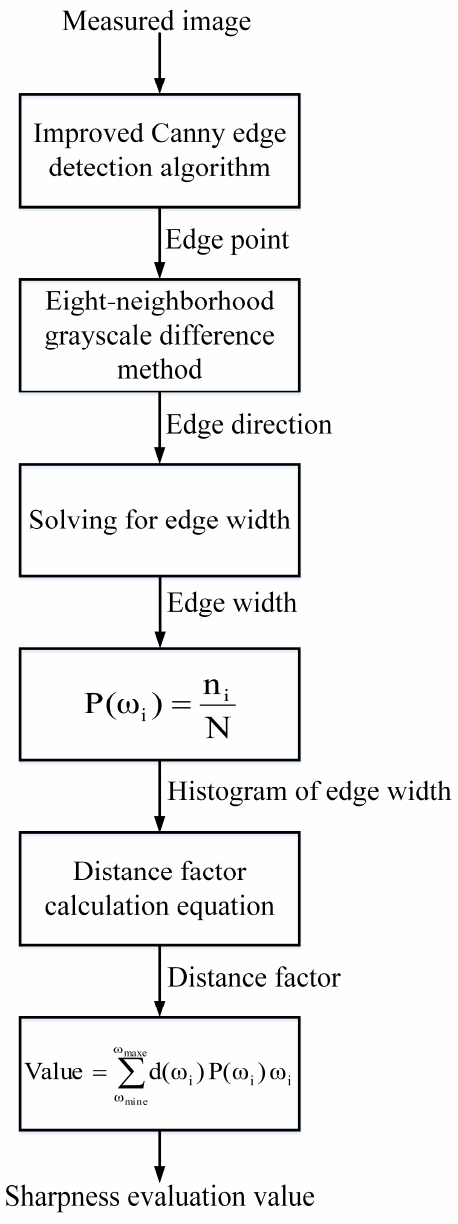
Figure 15. Flow chart of sharpness evaluation model.